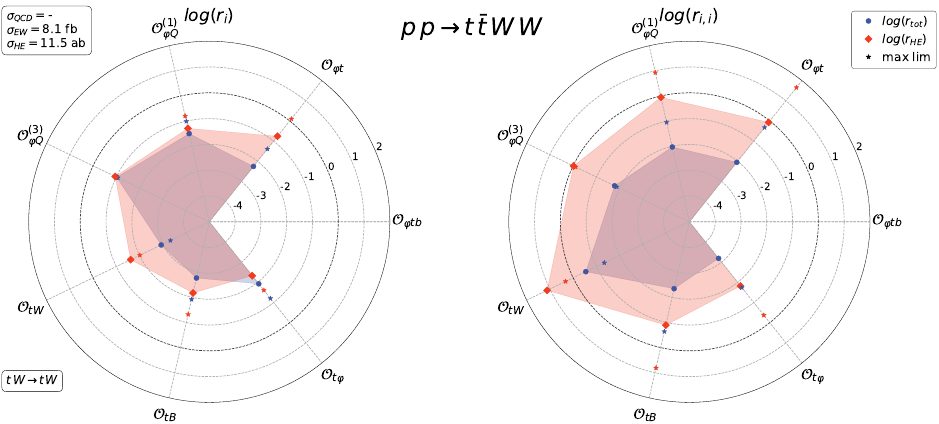
Figure 22. Radar plot for the p p t (cid:22) t W + W (cid:0) process at the 13 TeV LHC, see (cid:12)gure 7 and ! section 4.1.2 of the main text for a detailed description.